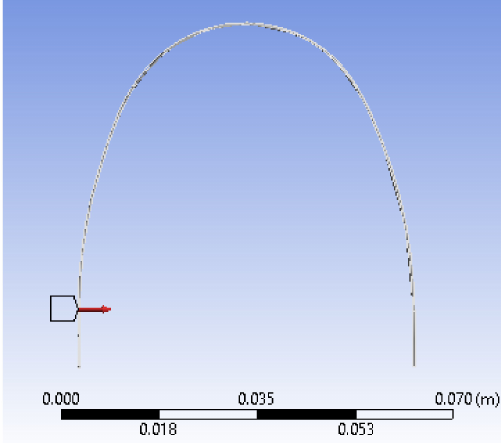
Figure 22. Position and direction of the force.